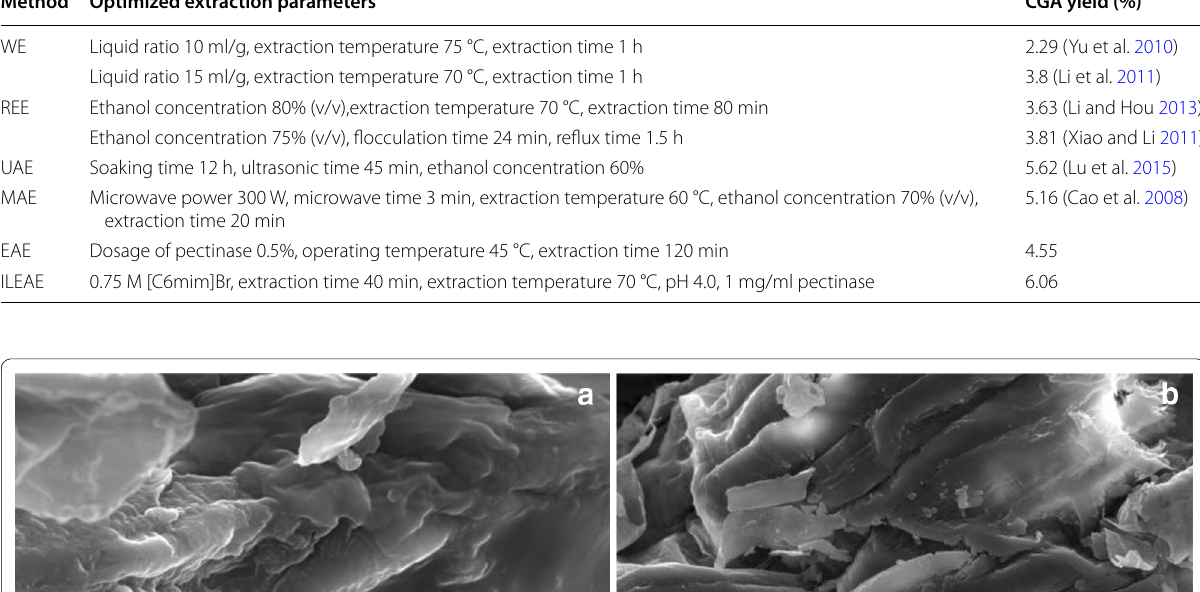
thinned, and the cell structure changed, which led to the target product exposed to the extraction solution. In the Fig. 4(d), after the mixed treatment of IL-enzyme, the cell wall surface tissue wrinkle serious and the cell wall thinner than a, b, c with the protrusions of the leaves disappeared. There is always a cell uplift in the leaves of the plant material, and the degree of protrusions in the treated sample can represent the dissolution and extrac- tion capabilities of the liquid solution.